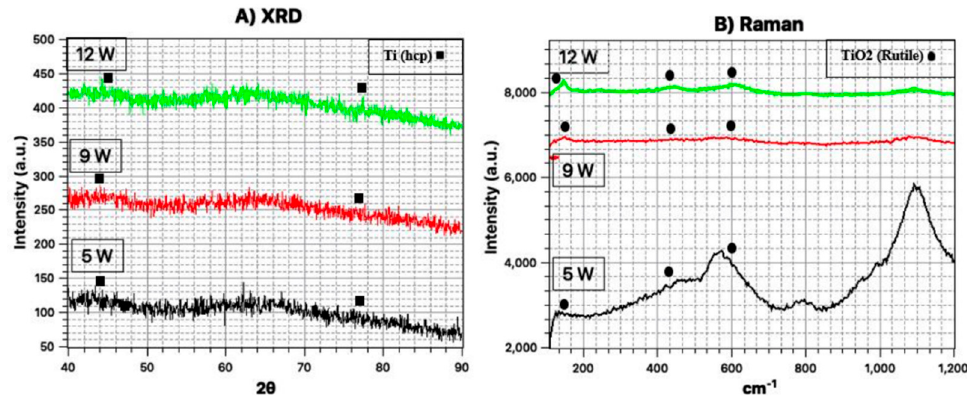
Figure 9. ( A ) X-ray diffraction ( XRD) pattern and ( B ) Raman spectrum of glass samples coated by titanium with different laser powers.